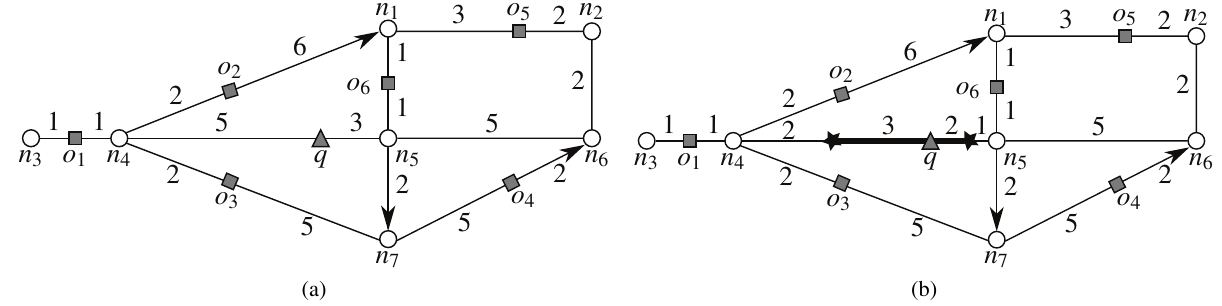
Figure 3: Examples (a) Example Road Network (b) Example Road Network with Safe